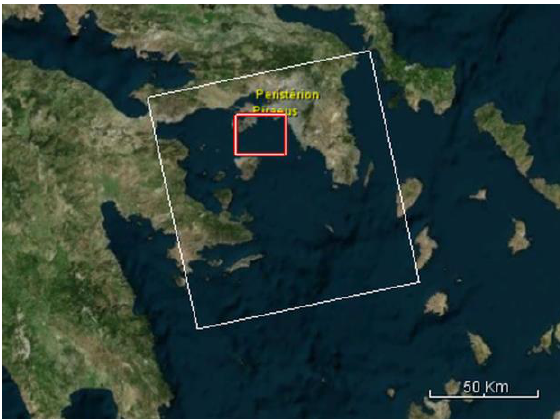
Figure 2. The dual-pol Envisat scene’s test